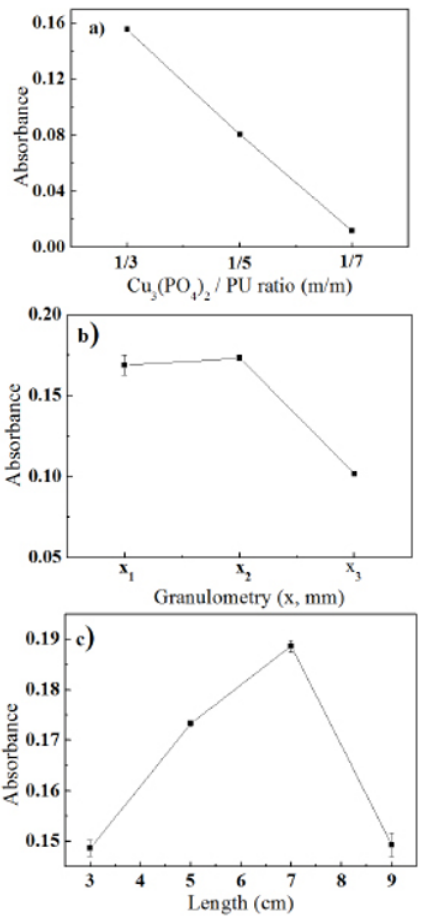
Figure 4. SPR Parameters. Evaluation of (a) Cu ratio (m/m), (b) particle size, and (c) SPR length. 5.0×10 −4 M AA and 1.5×10 −3 M bathocuproine were used with deionized water carrier.